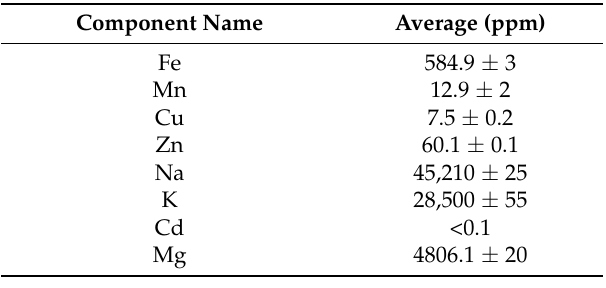
Table 3. Methane content and production for the different Biochemical Methane Potential (BMP) test